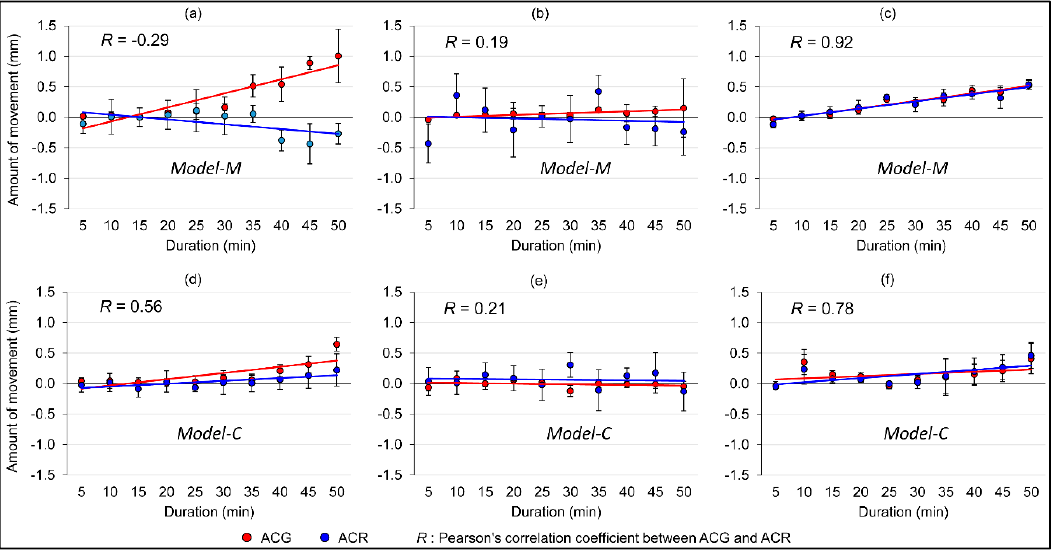
Figure 9. Average amount of 3D movement of the ACG and the ACR. ( a ) X ‐ axis, ( b ) Y ‐ axis, ( c ) Z ‐ axis on Model ‐ M, and ( d ) X ‐ axis, ( e ) Y ‐ axis, ( f ) Z ‐ axis on Model ‐ C.